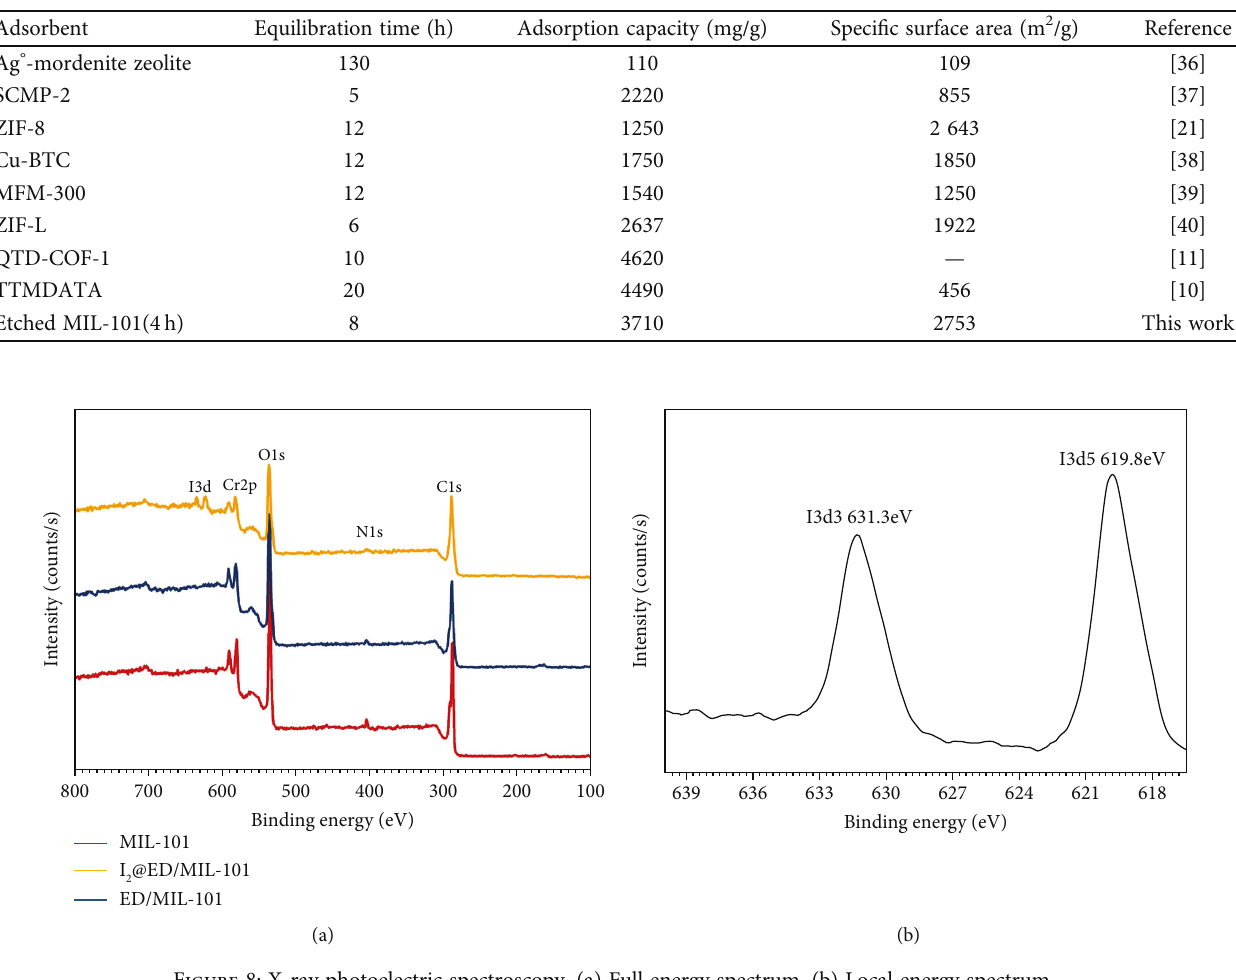
Figure 7: (a) The adsorption capacity of etched MIL-101 (4 h) for di ff erent initial mass of iodine. (b) The adsorption kinetics of etched MIL- 101(4h) and MIL-101. Table 2: Comparison of iodine adsorption capacities of as-prepared etched MIL-101(4 h) with other adsorbents reported in the literature.